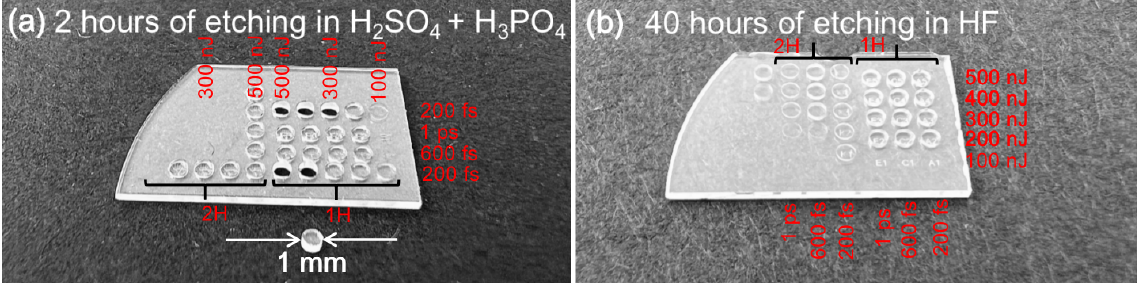
Figure 3. Cylindrical structures written with different wavelengths and pulse duration radiation. ( a ) Structure etched in H 2 SO 4 and H 3 PO 4 mixture, ( b ) structure etched in HF